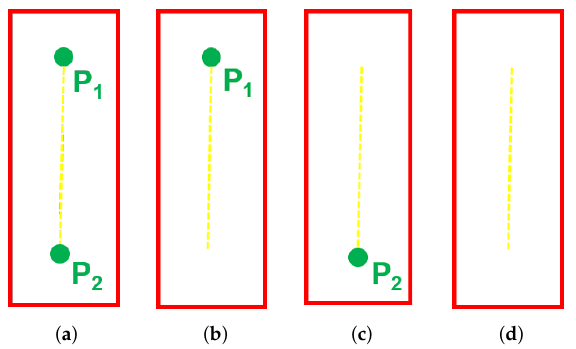
Figure 5. The relationship between two marking points p 1 , p 2 and the bounding box of the parking slot head B . ( a ) shows p 1 ⊆ B and p 2 ⊆ B ; ( b ) shows p 1 ⊆ B and p 2 (cid:54)⊂ B ; ( c ) shows p 1 (cid:54)⊂ B and p 2 ⊆ B ; ( d ) shows p 1 (cid:54)⊂ B and p 2 (cid:54)⊂ B